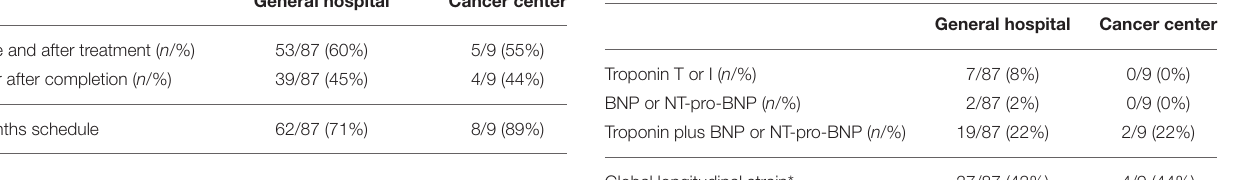
TABLE 2 | Use of cardiac biomarkers (upper panel) and global longitudinal strain (lower panel) in the routine monitoring of cancer patients receiving anthracyclines by center